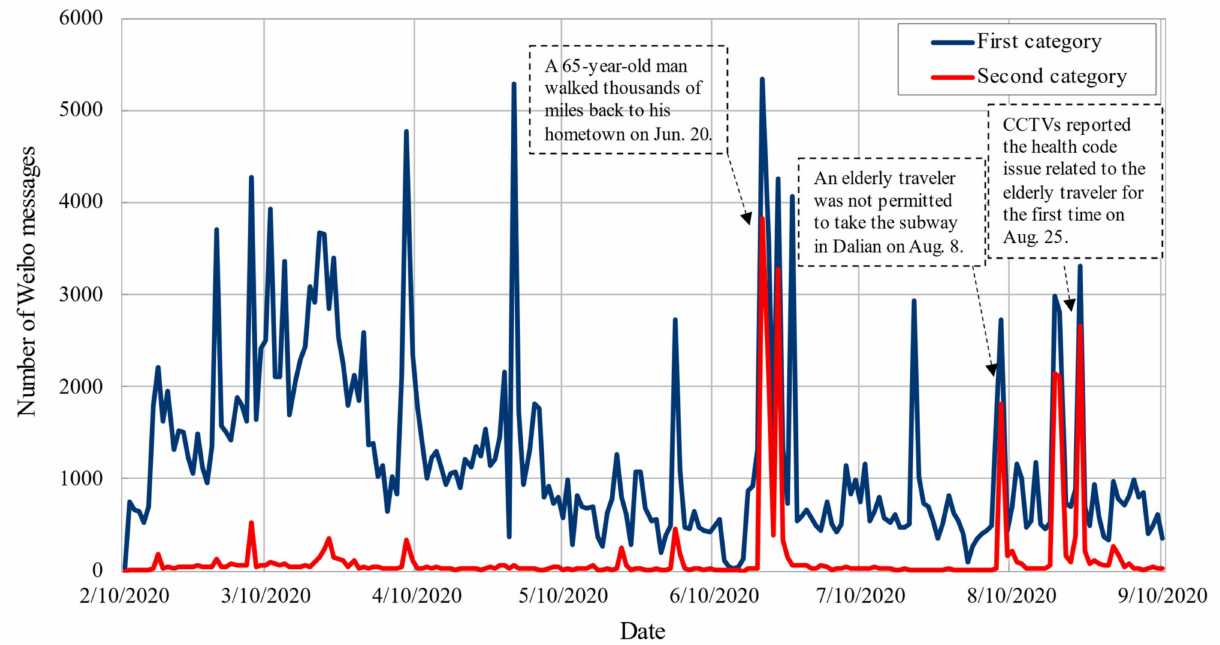
Figure 5. Temporal patterns of the volume of Weibo messages by